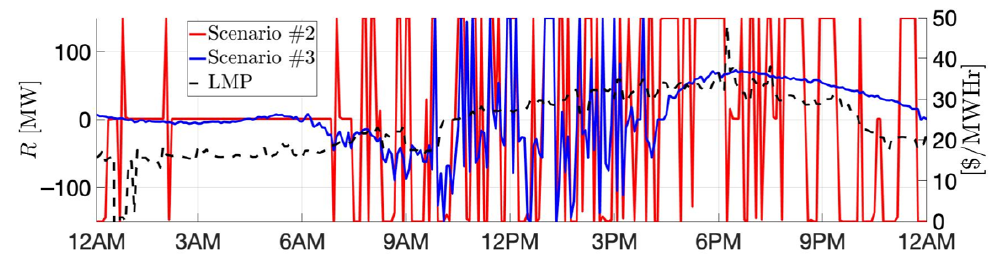
Figure 4. The net procurement P 0 for all three scenarios.